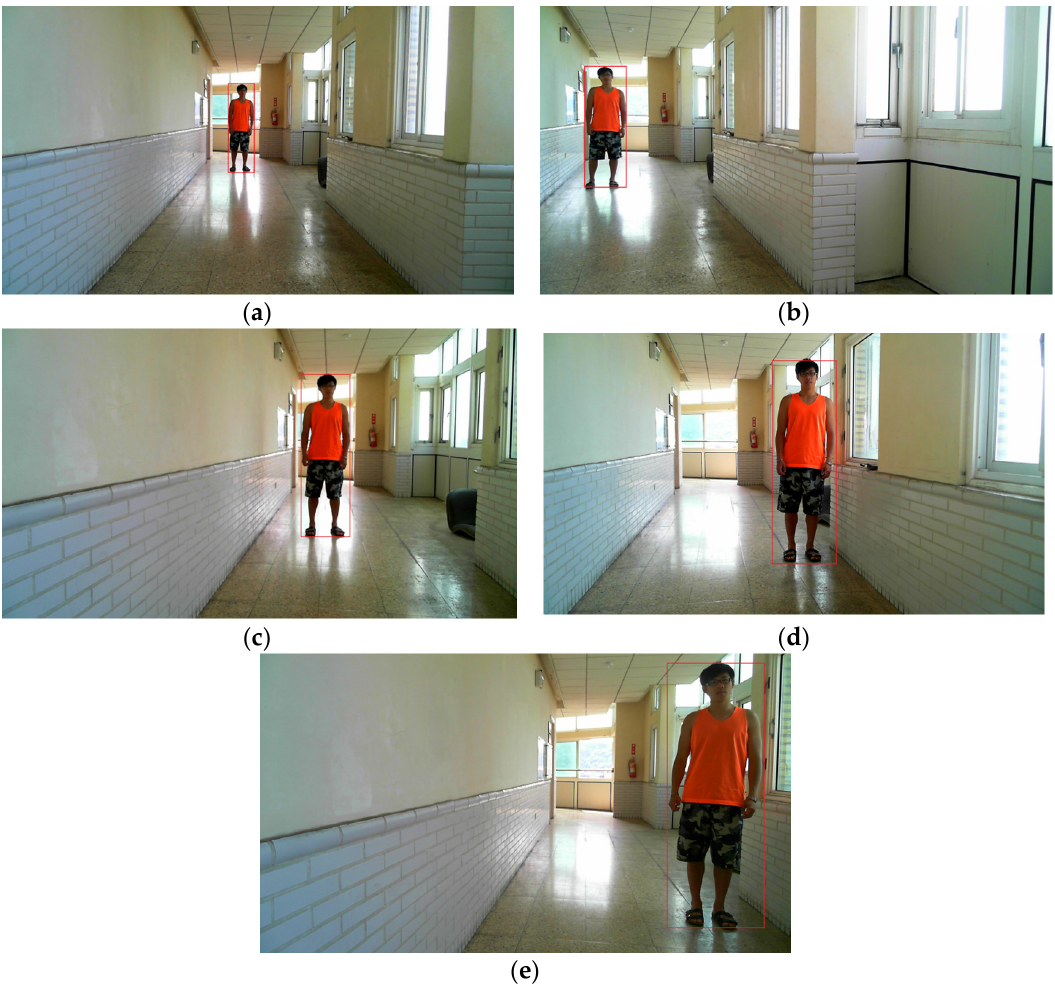
Figure 8. Steps for tracking a moving object against a dynamic background: ( a ) Find the object; ( b ) scroll right; ( c ) the object moves forward; ( d ) the object moves; ( e ) keep tracking the object.